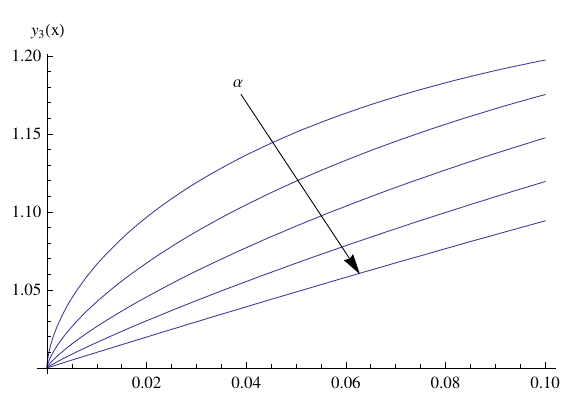
Figure 4. The approximate solution for α = 0.6, 0.7, 0.8, 0.9,